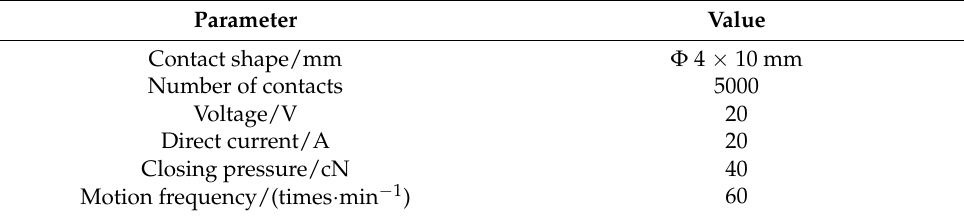
Table 1. Parameters of the electrical contact test.